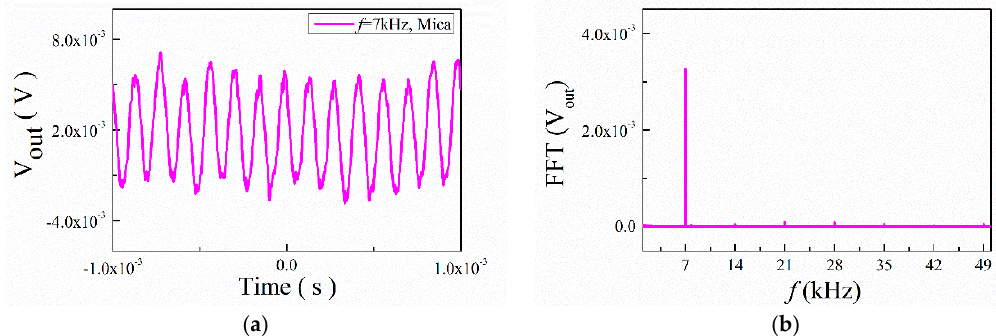
Figure 10. ( a ) Waveforms of ME voltage in the time domain for the ME structure with mica trestle at 7 kHz; ( b ) the FFT spectral pattern for ME voltage.